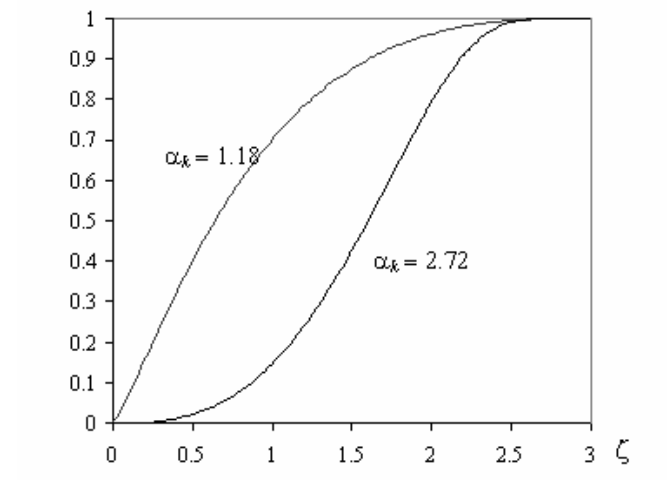
(cid:32) 0, (cid:86) (cid:32) 1. k k